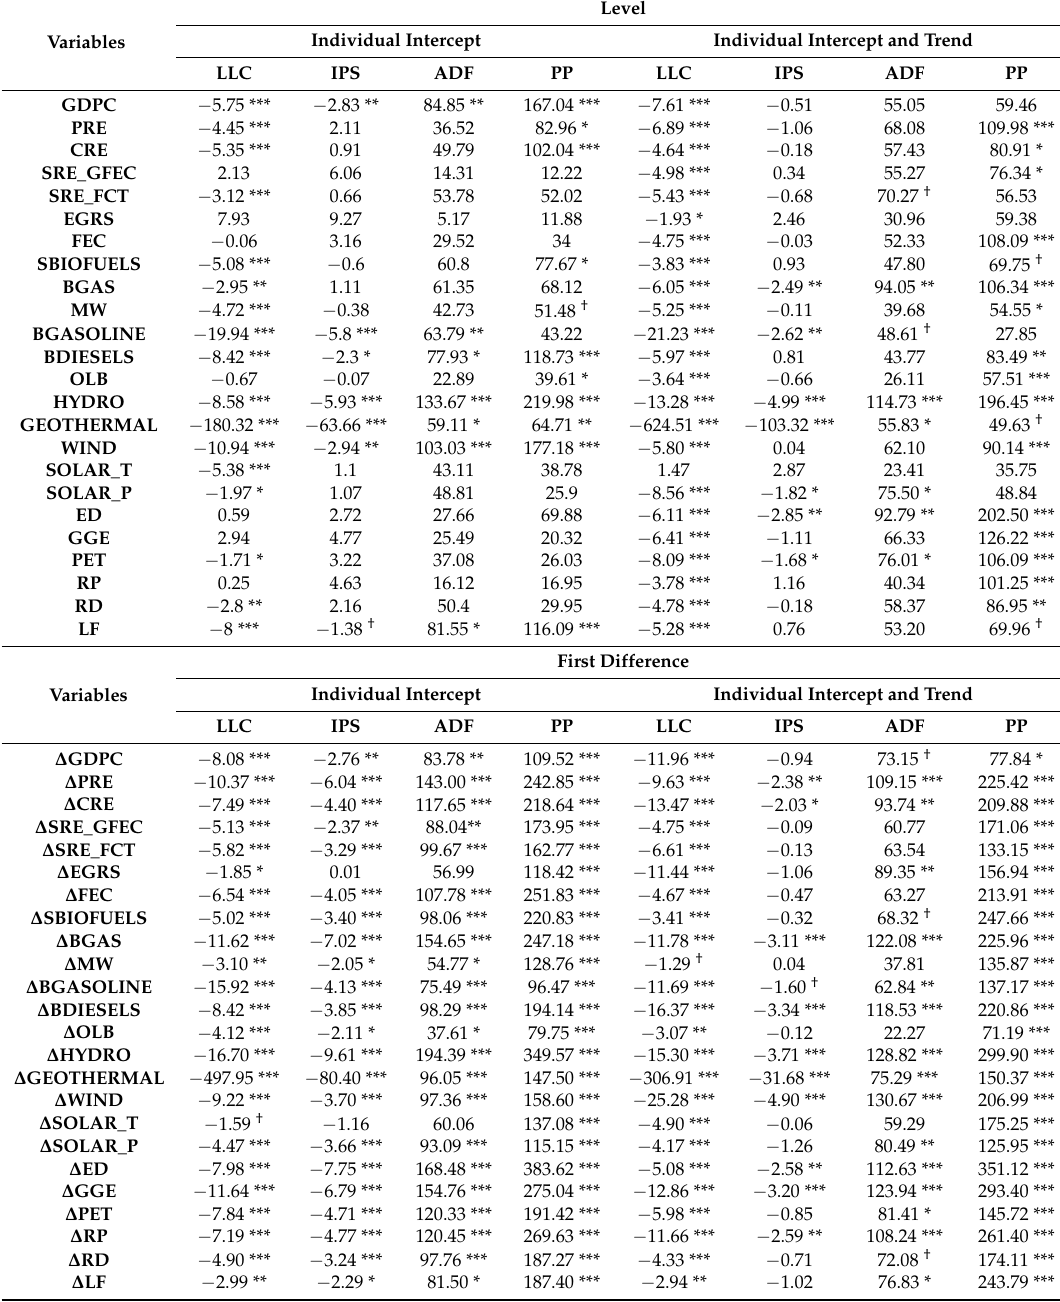
Table 5. Panel unit root test